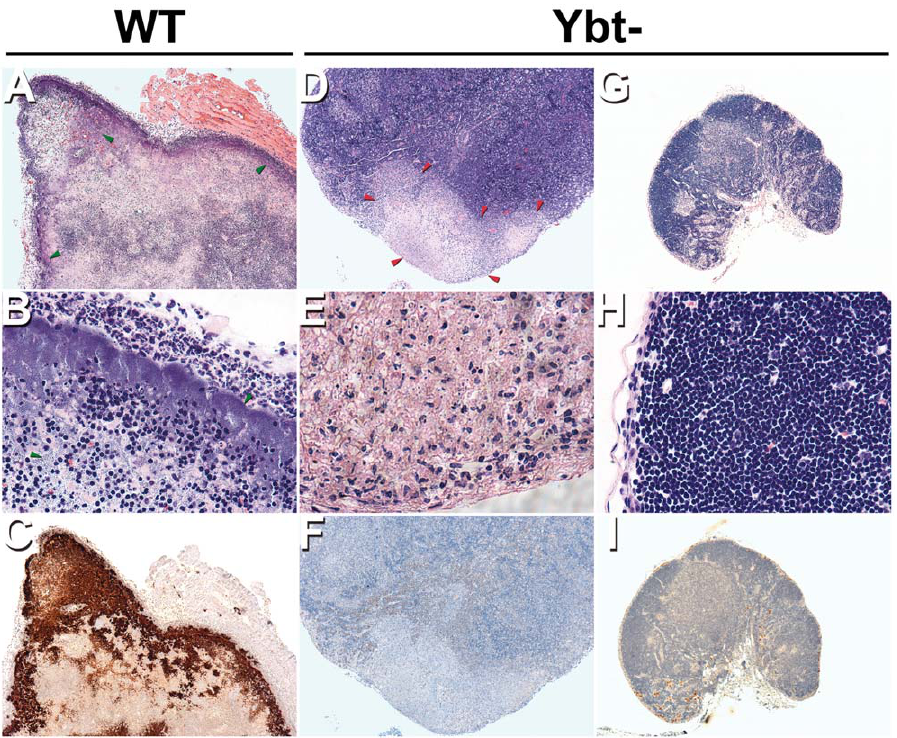
Figure 2. Lymph node histology of mice with terminal plague following flea-borne transmission of wild-type and D irp2Y.pestis. Lymph node sections from mice infected with the wild-type strain (A to C) or with the D irp2 strain (D to I) were strained by H&E (A, B, D, E, G and H) or by IHC using Y. pestis -specific antibody (C, F and I). Panels D, E and F and the panels G, H and I are photos of the lymph node from mouse with and without lymphadenitis respectively. Masses of bacteria, indicated by green arrowheads, stained dark brown by IHC and blue by H&E. Red arrowheads show tissue destruction in the sick mouse infected with the D irp2 mutant. The lymph nodes (G, H and I) have an identical normal histology to uninfected lymph node [14]. Magnification, 40x (A, D, G, C, F and I) and 400x (B, E and H). doi:10.1371/journal.pone.0014379.g002 PLoS ONE |